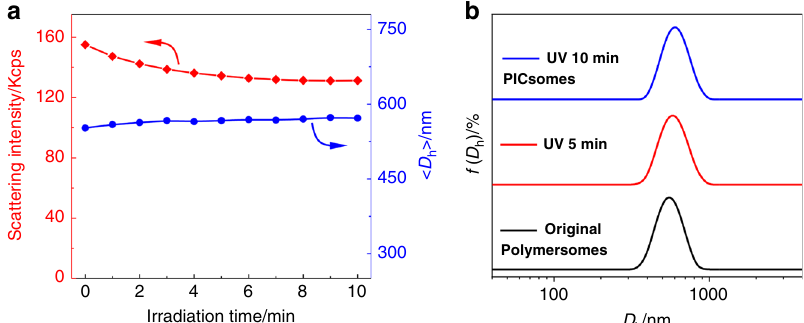
Fig. 4 DLS characterization of polymersome-to-PICsome transition upon UV irradiation. a Irradiation duration-dependent evolution of scattered light intensities and 〈 D h 〉 recorded for PEO 45 - b - P(NCMA 0.55 - co -DPA 0.45 ) 29 vesicles in neutral aqueous media. b Intensity-average hydrodynamic diameter, D h , distributions before and after UV